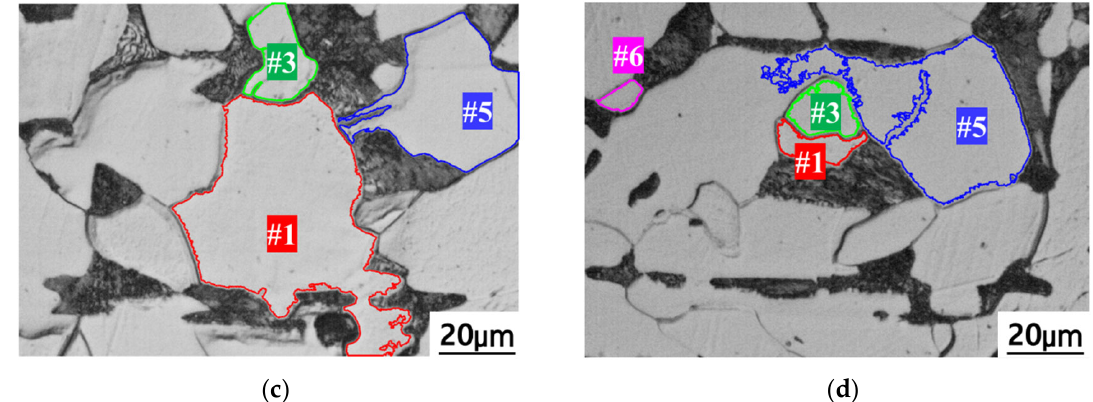
Figure 7. Boundaries at several layers. ( a ) 3rd layer; ( b ) 7th layer; ( c ) 10th layer; and ( d ) 26th layer.